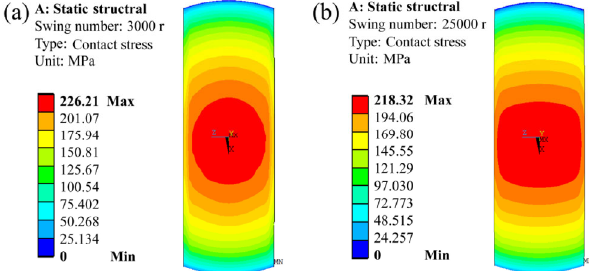
Fig. 5 Contact pressure distribution of fabric liners after different swing numbers: (a) 3,000 times and (b) 25,000 times.